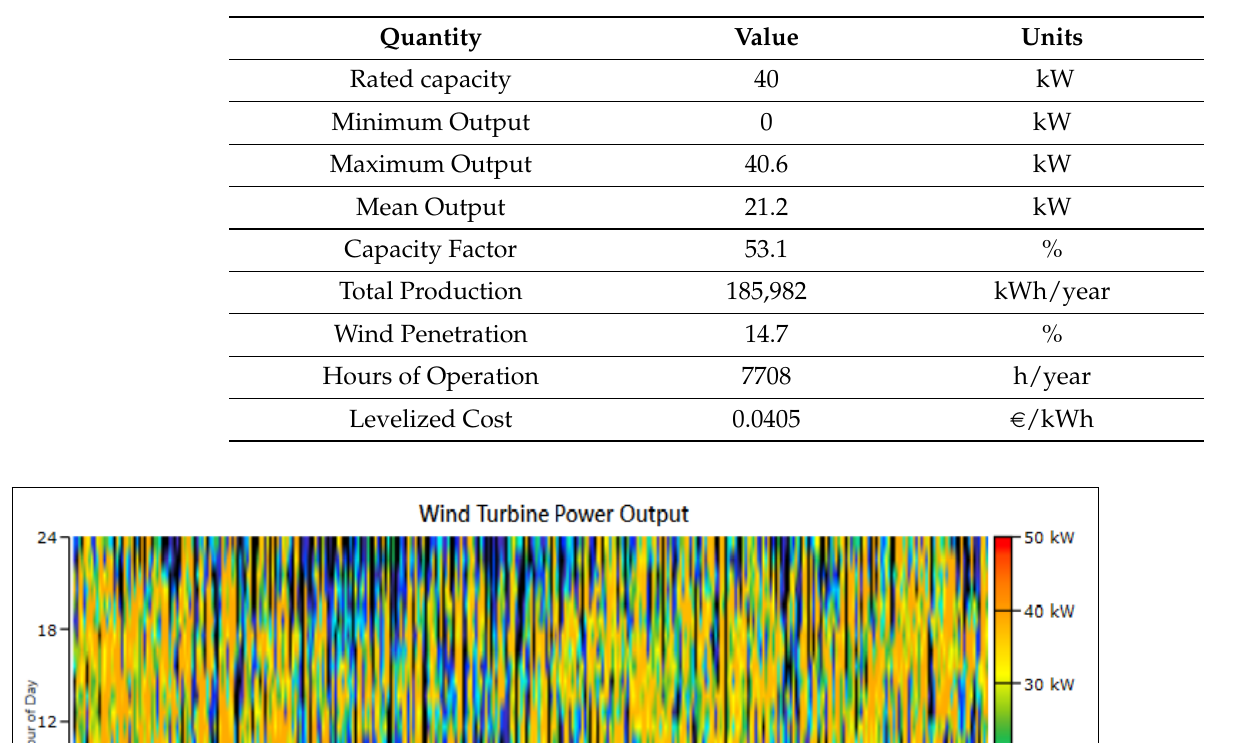
Table 17. Eocycle EO20 (20 kW) Scheme Simulation Results.